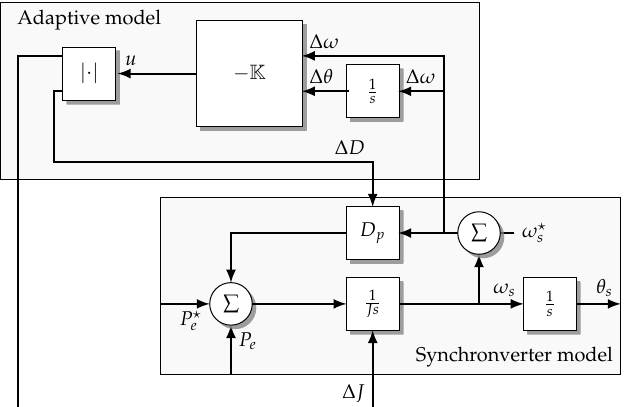
Figure 3. Proposed adaptive virtual inertia